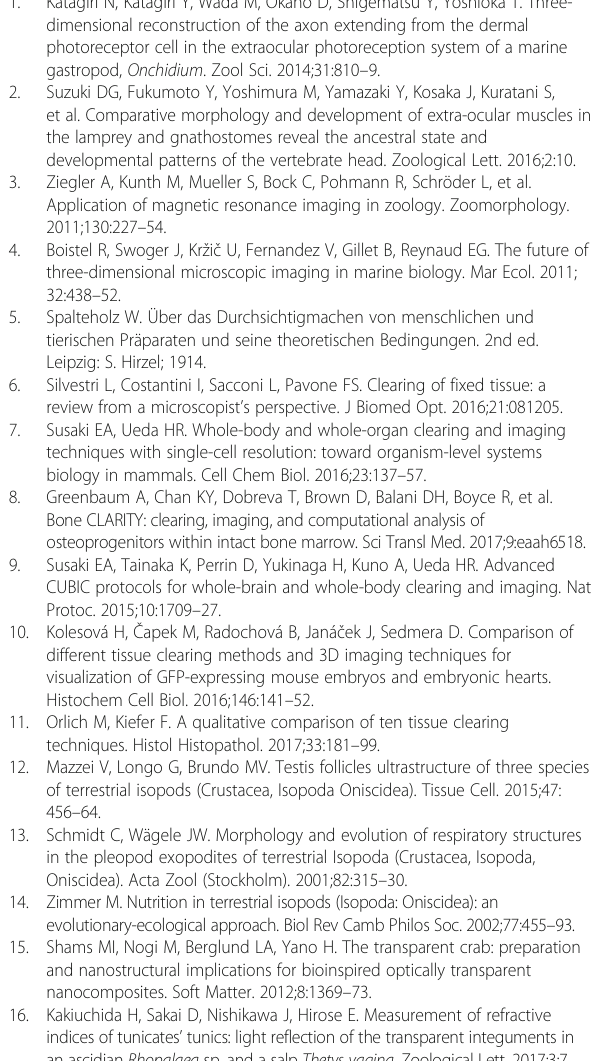
Additional file 1: Figure S1. Effect of EDTA treatment on the exoskeleton of A. vulgare (A), a cheliped of Philyra sp. (B), and a leg of V. analis (C). (JPG 420